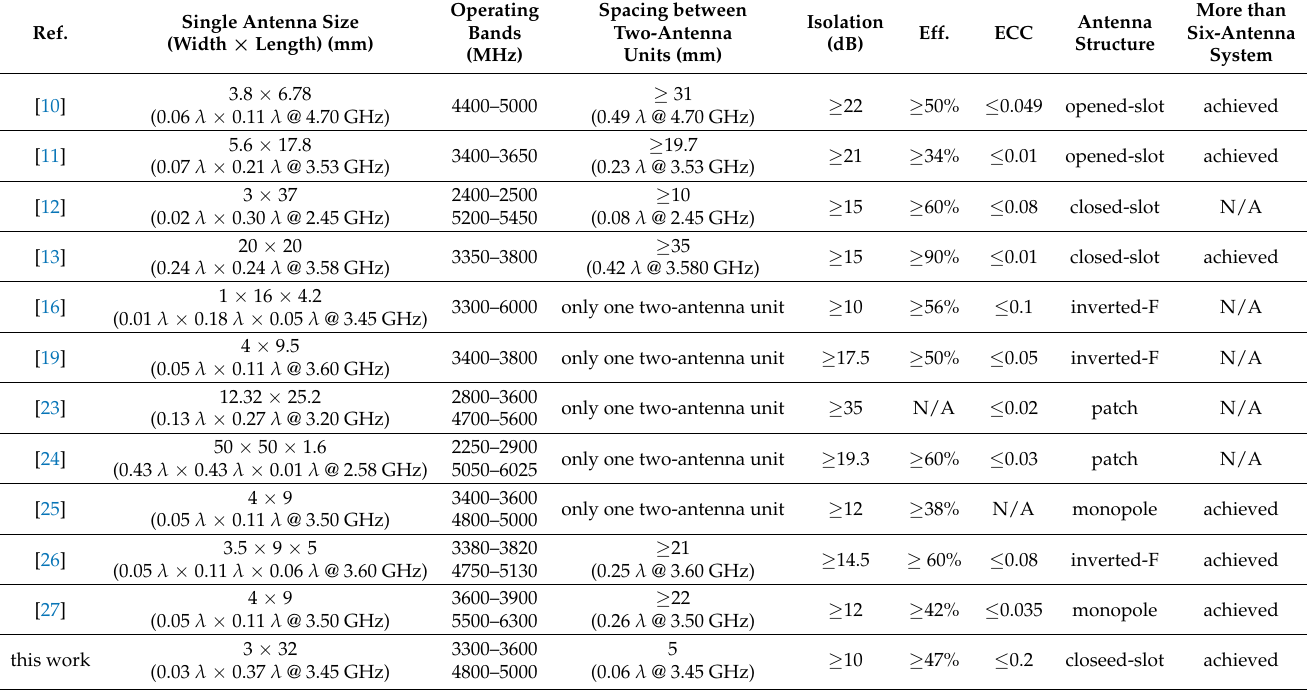
Table 1. Performance comparison of MIMO antenna